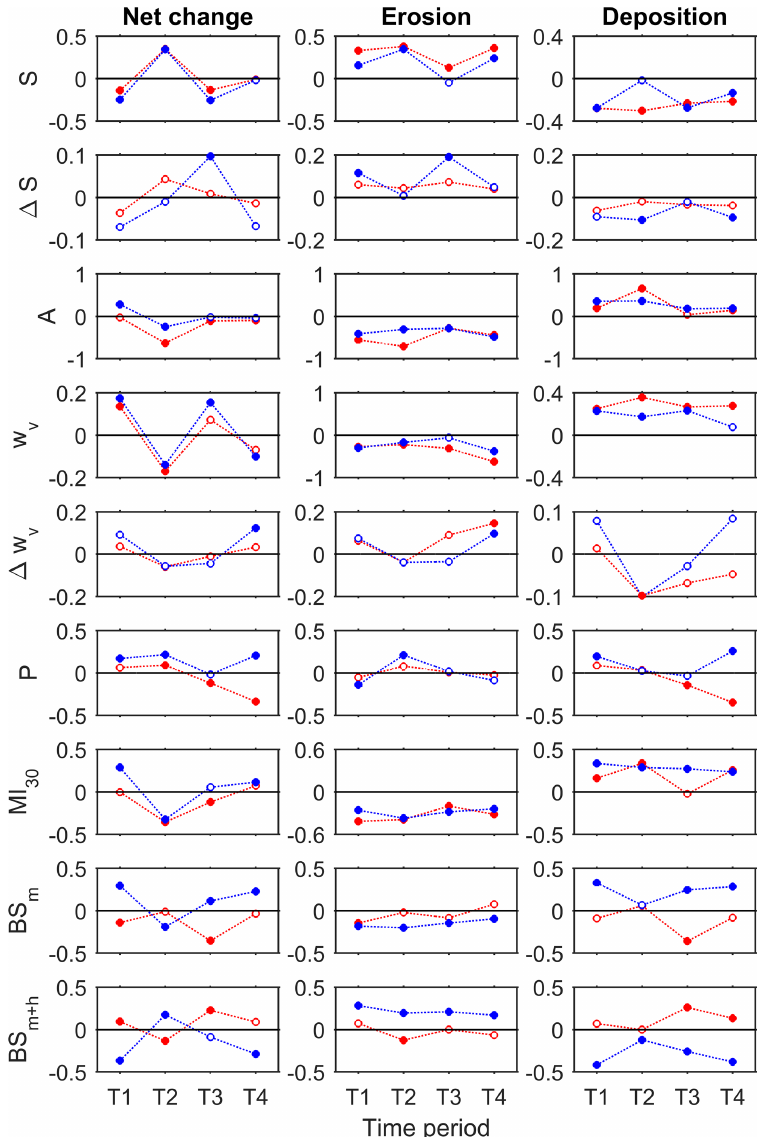
Figure 10. Pearson correlation coefficients for Skin Gulch (dotted red lines) and Hill Gulch (dotted blue lines) for each time period between the independent metrics and the dependent variables of net volume change, total erosion, and total deposition, respectively. T1 to T4 are for the time periods (T#) of 201210–201307, 201307–201310, 201310–201409, and 201409–201506, respectively. Independent variables include channel slope ( S ), change in channel slope (cid:49)S , contributing area ( A ), valley width ( w v ), change in valley width ( (cid:49)w v ), total precipitation ( P ), maximum 30min intensity (MI 30 ), percent burned at moderate severity (BS m ), and percent burned at moderate and high severity (BS m + h ). Filled circles indicate correlations that are significant at p value ≤ 0.05. Note that the vertical axes vary according to the strength of the